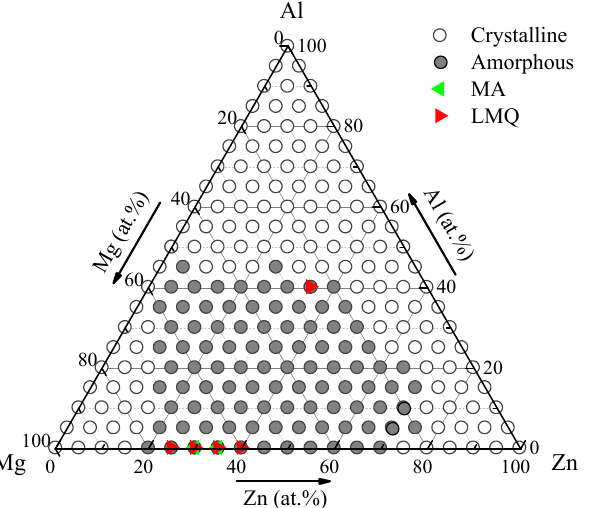
Figure 3. The glass formation stoichiometry diagram obtained from MD simulations at 300 K for the Al-Mg-Zn system.